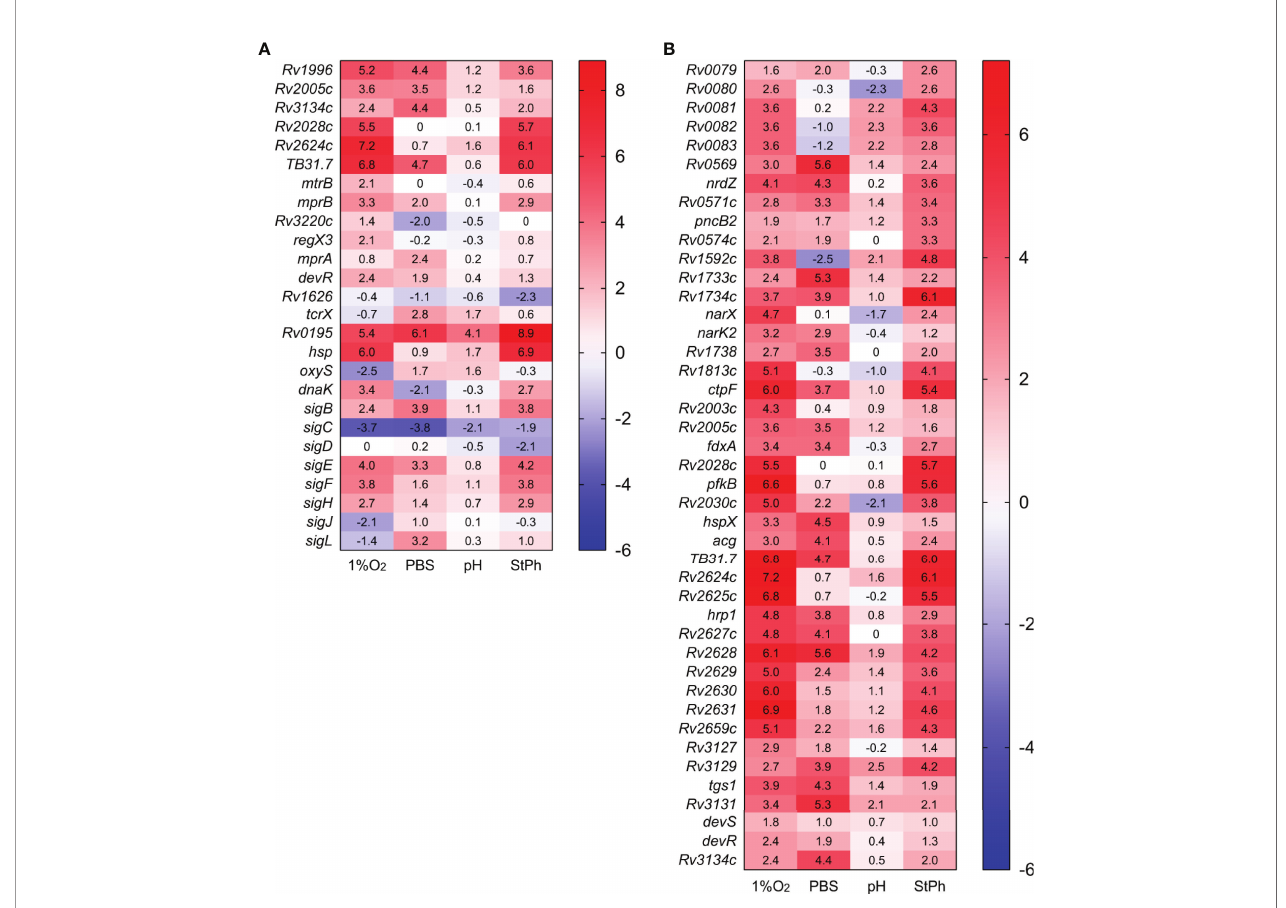
FIGURE 2 | Heat map of genes differentially expressed in stress conditions (A) or in the dormancy regulon (B) . The log2 fold change for each gene and condition is indicated in the